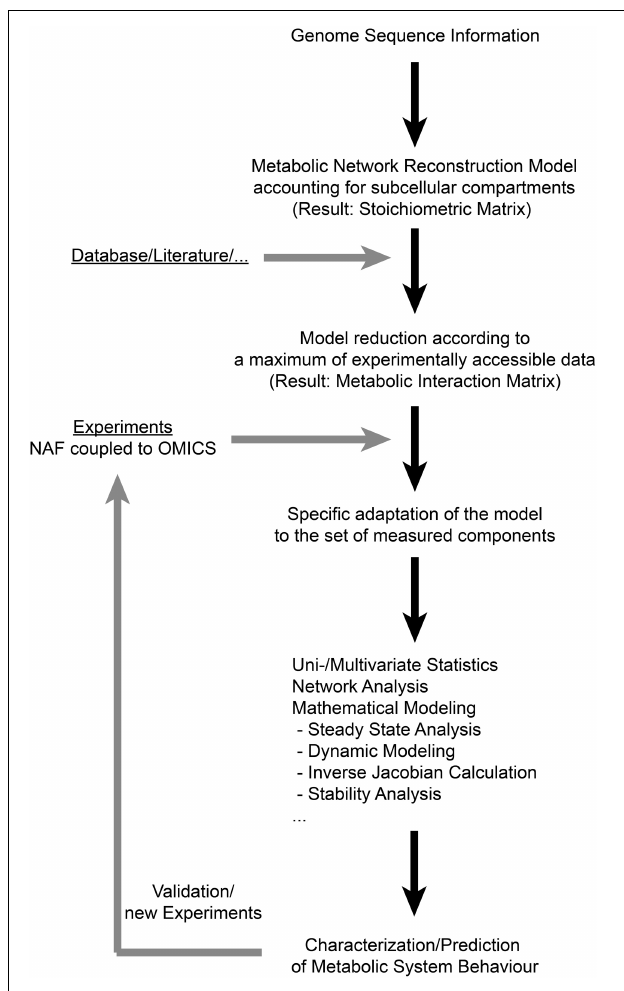
FIGURE 2 | A workflow for deriving subcellular metabolic network structures according to experimental data sets. In the present study, the first step of deriving a genome-scale metabolic network reconstruction model was not performed, but a published reconstruction work was applied instead (Mintz-Oron et al., 2012). NAF: Non-Aqueous